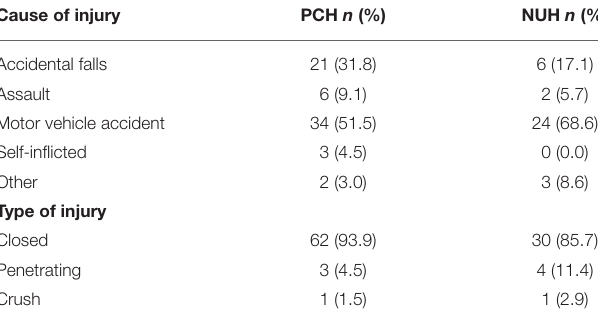
TABLE 1 | Cause and type of